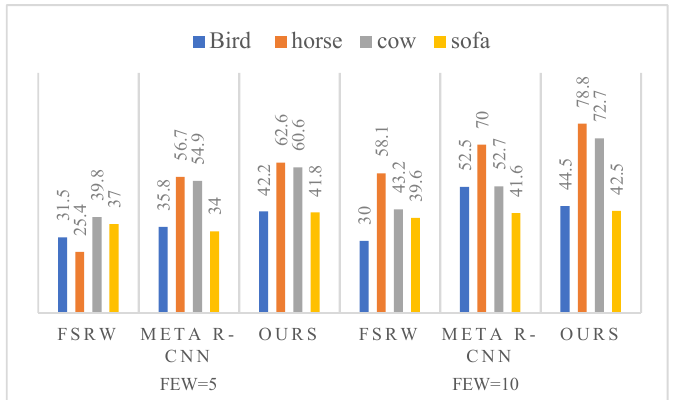
Figure 5. The second experiment on relation reasoning. Sofa has almost no association with other classes (mbike, bus, car). The performances of correlated classes (mbike, bus, car) are increased slightly.